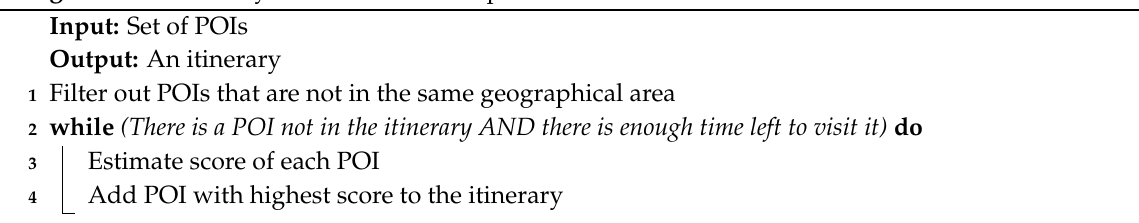
Algorithm 1: Itinerary